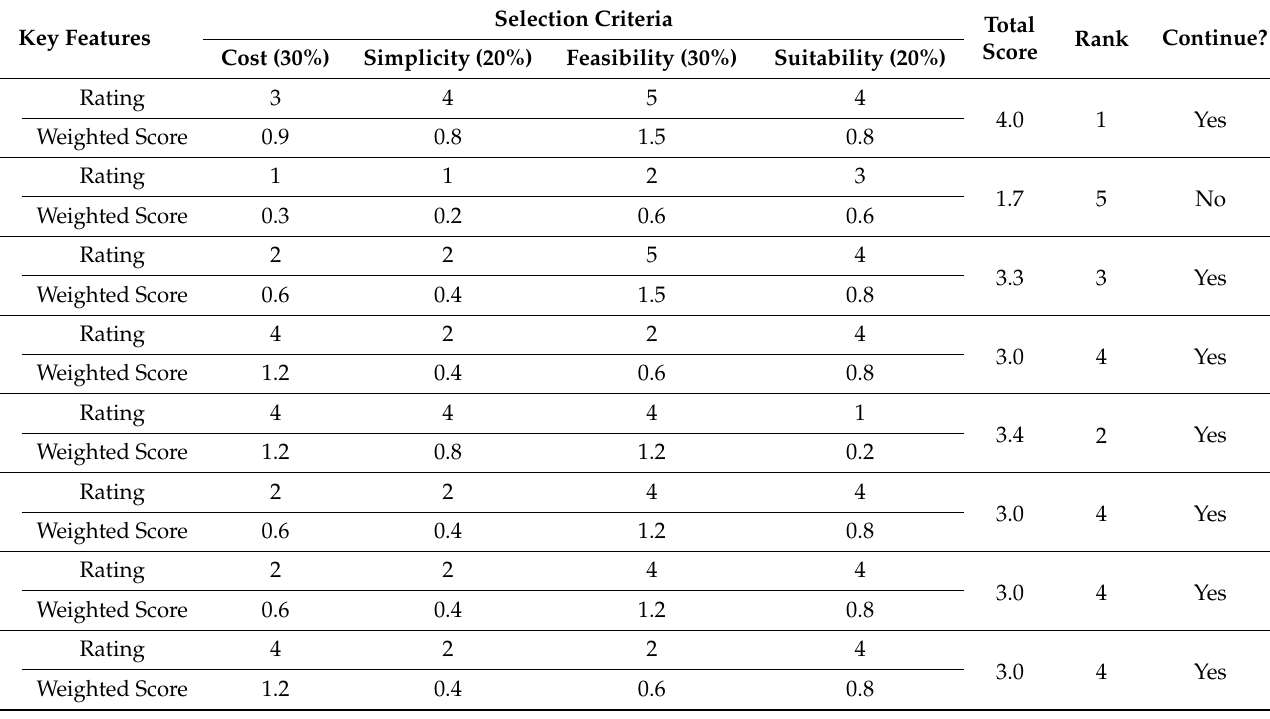
Table 15. Suggested solutions and evaluations.